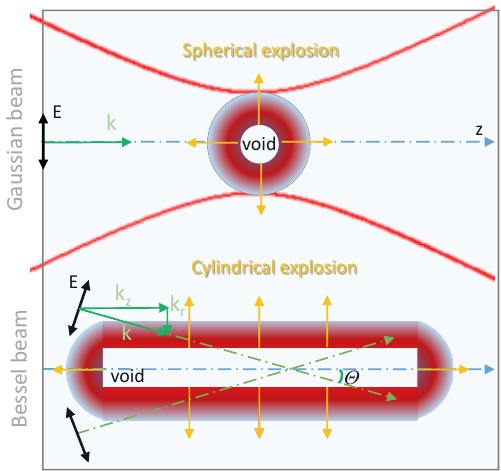
Figure 1. Schematic presentation of radial microexplosion-driven inside a transparent material by a focused linearly-polarised (E-field) Gaussian beam (GB) and Bessel beam (BB) with projection E z along the optical axis (z-axis); θ is the angle with the optical axis (wavevector k = upper half of the conical wave). Resonant absorption of the E r component (along the radial direction k r ) allows a higher energy density deposition for the cylindrical microexplosion. With the central void diameter in sapphire comparable for the GB [1] and BB [8] pulses, the volume was 180-times larger in the case of